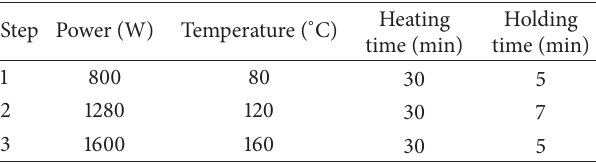
Table 1: The programmed microwave-assisted digestion conditions for ICP-AES analysis of MFLW